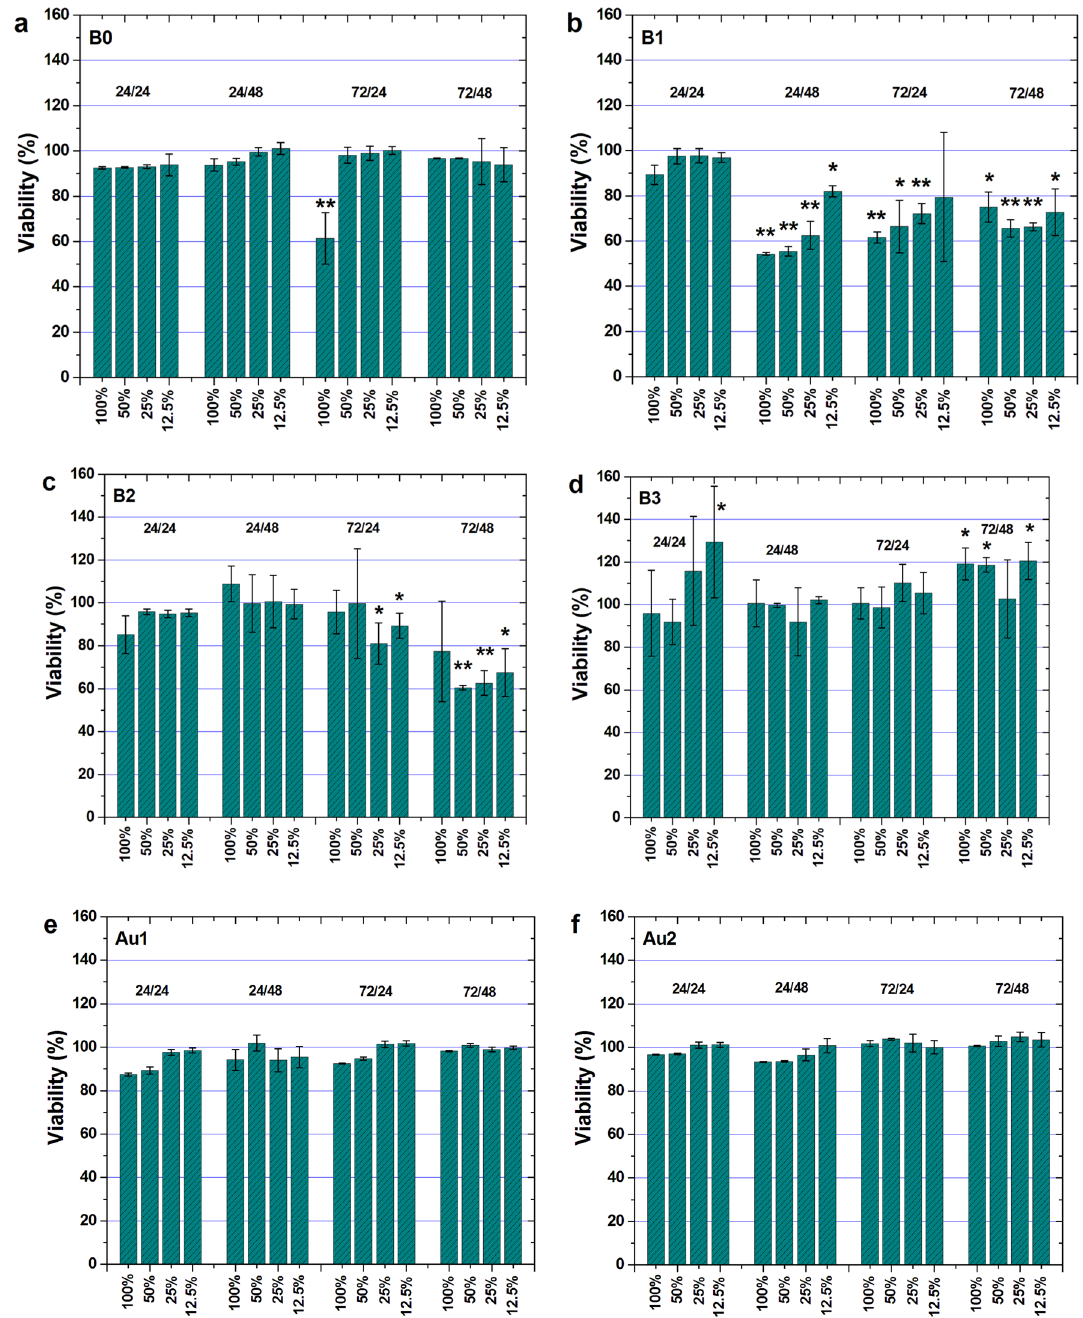
Figure 5. Cytotoxicity of U2-OS cells cultured in extraction mediums after 24 and 48 h of incubation for alloys: ( a )